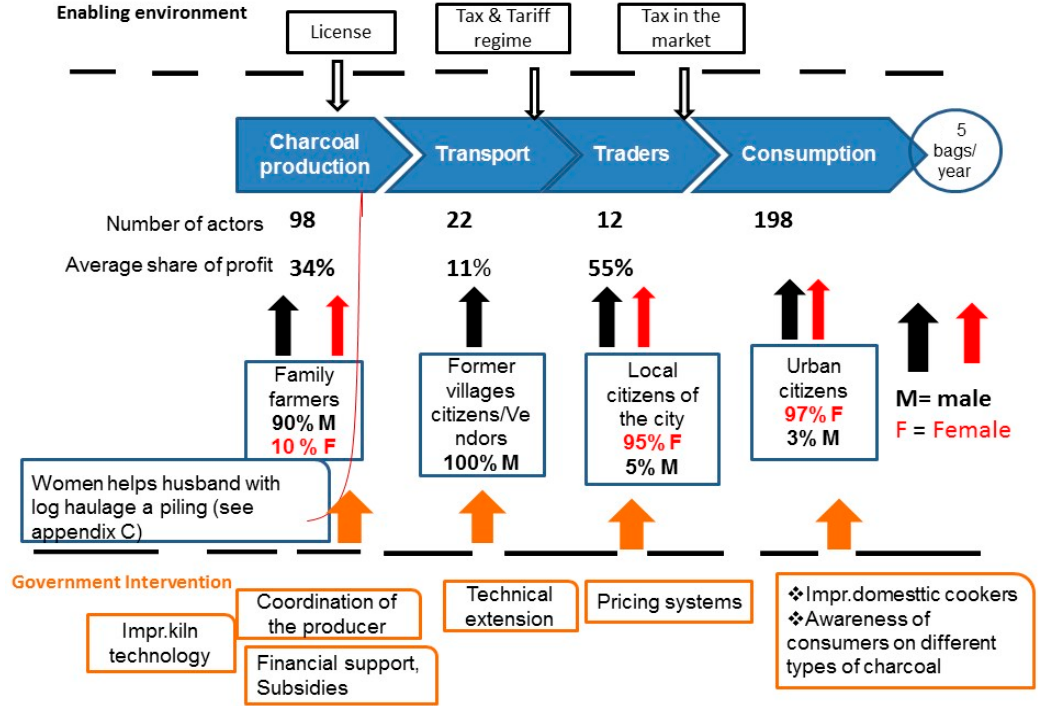
Figure 4. Illustration of the charcoal value chain in Bié province of Angola.